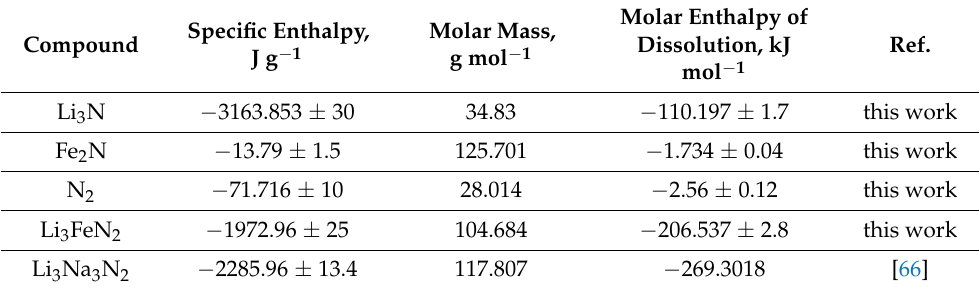
Table 3. Values of specific and molar enthalpies of dissolution (298 K, p = 101 kPa, 1 mol dm − 3 HCl).